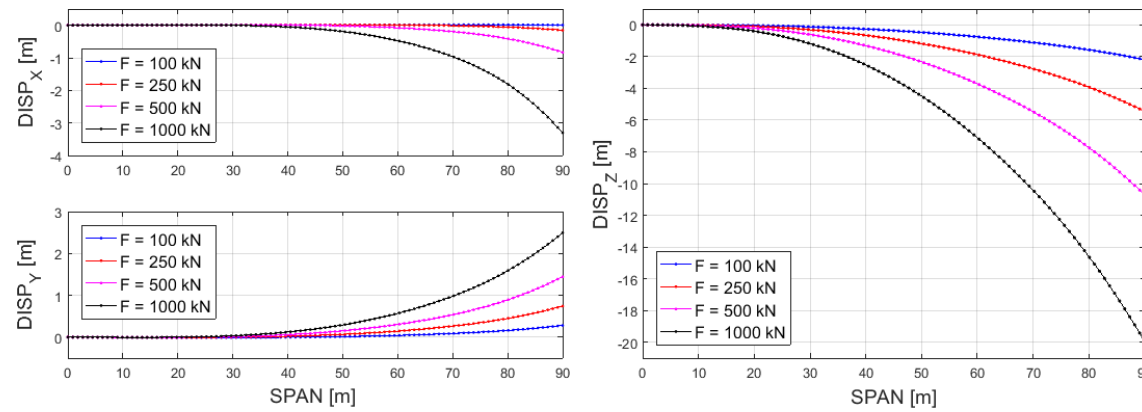
Figure 7. Displacement of the reference centre-line points with 3D BLM for increasing F